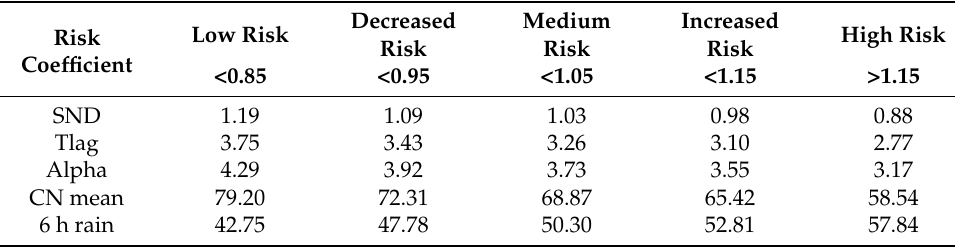
Table 4. Values of individual parameters used to express the degree of risk in relation to the mean values of the parameters.